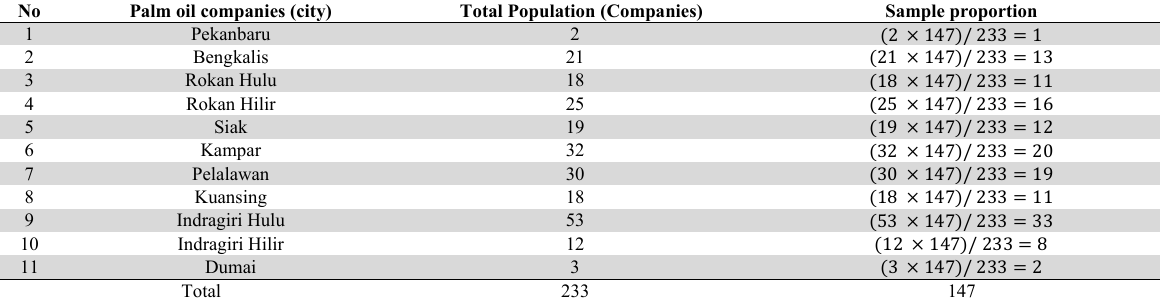
The Sample Proportion of Palm Oil Industries in Riau